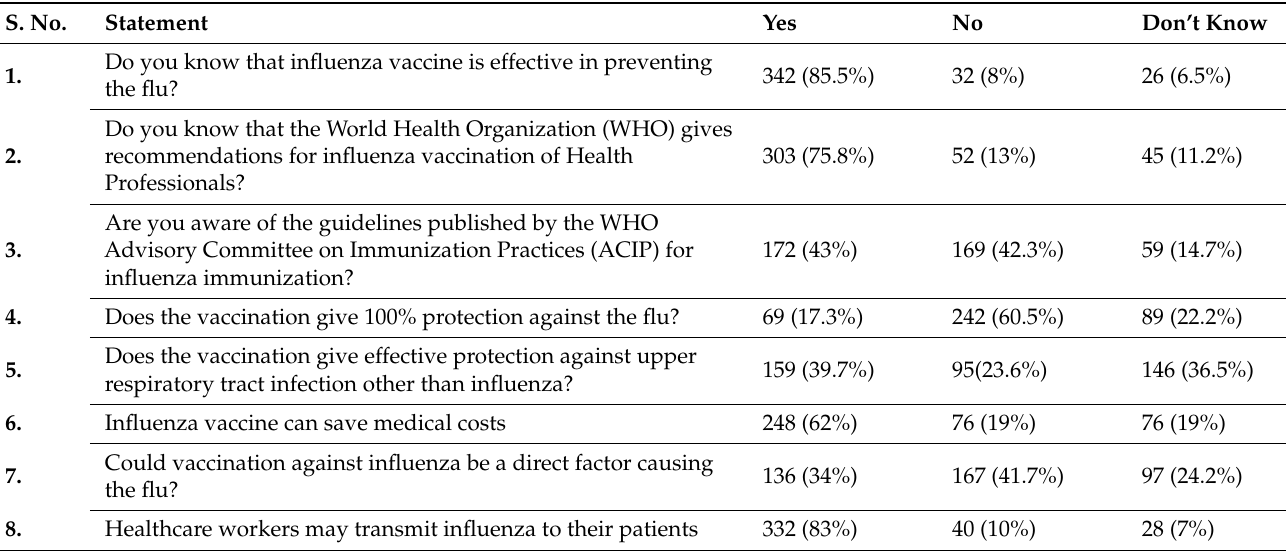
Table 2. Health care professionals’ knowledge about influenza